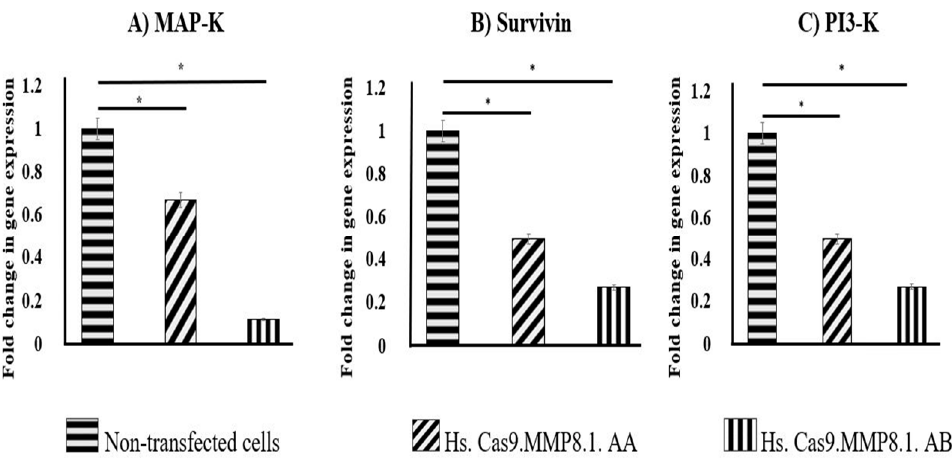
Figure 6. Fold change in gene expression. Reduced gene expression of MAP-K ( A ), survivin ( B ) and PI3-K ( C ) in the groups transfected with Hs.Cas9.MMP8.1.AA and Hs.Cas9.MMP8.1.AB gRNAs